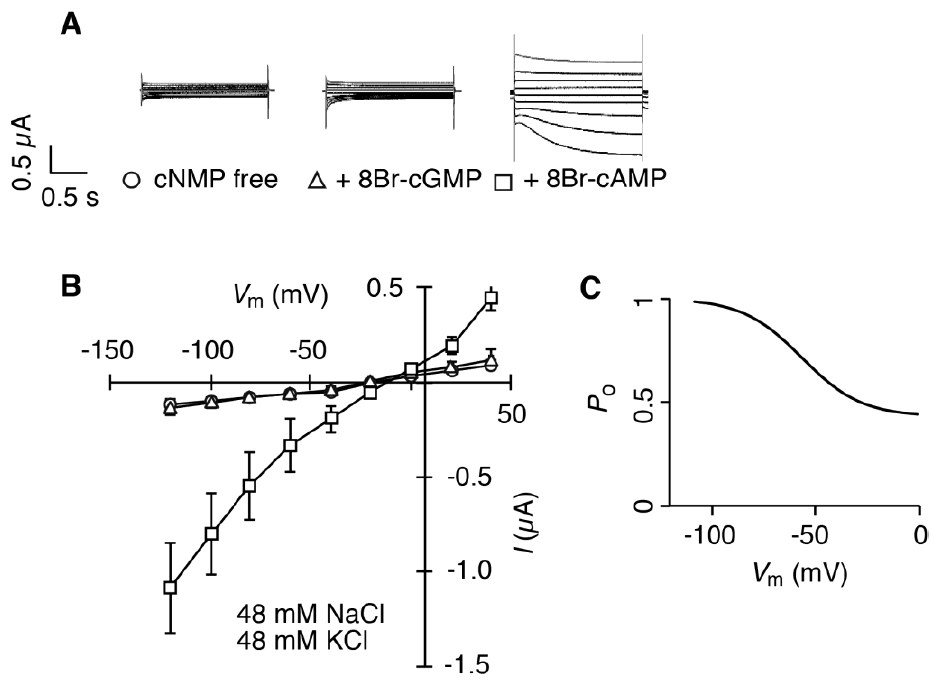
Figure 4. Current/voltage relationship of HvCNGC2-3 -expressing oocytes in a 1:1 mixture of Na + and K + media. Currents were recorded by the two-electrode voltage-clamp technique in a bathing solution containing 48 mM NaCl and 48 mM KCl in the absence of a pre-incubation with cyclic nucleoside monophosphates (cNMP-free, circles), and in the presence of a pre-incubation with 10 µM 8Br-cGMP (triangles) or 8Br-cAMP (squares) for 30 min. ( A ) representative raw recording traces; ( B ) current/voltage curve. Error bars indicate standard deviation ( n = 7, 13 and 9 for cNMP-free, 8Br-cGMP and 8Br-cAMP, respectively). I , membrane current. V m, membrane potential; ( C ) P o , apparent open probability fitted with modified Boltzmann equation.